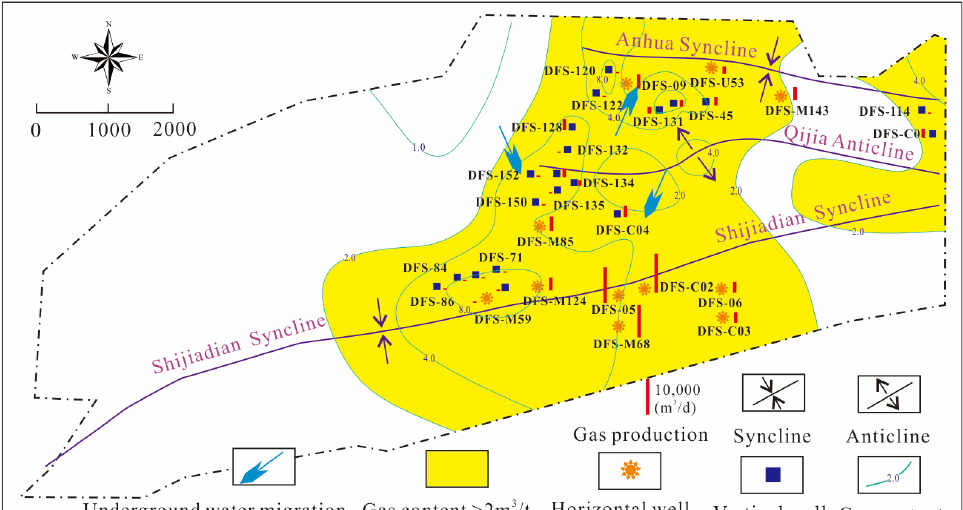
Figure 11. The relationship between gas production and structure.